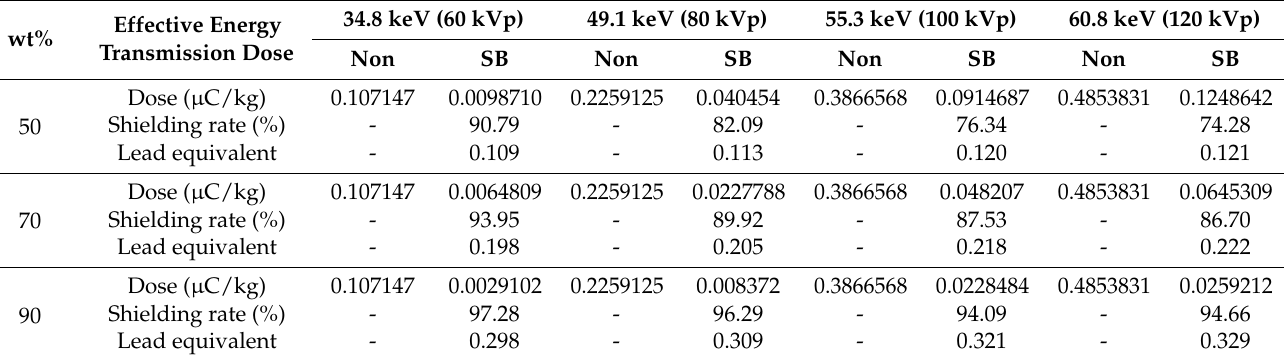
Table 3. Comparison of tungsten content change and shielding performance based on the internal conditions of the injection molding